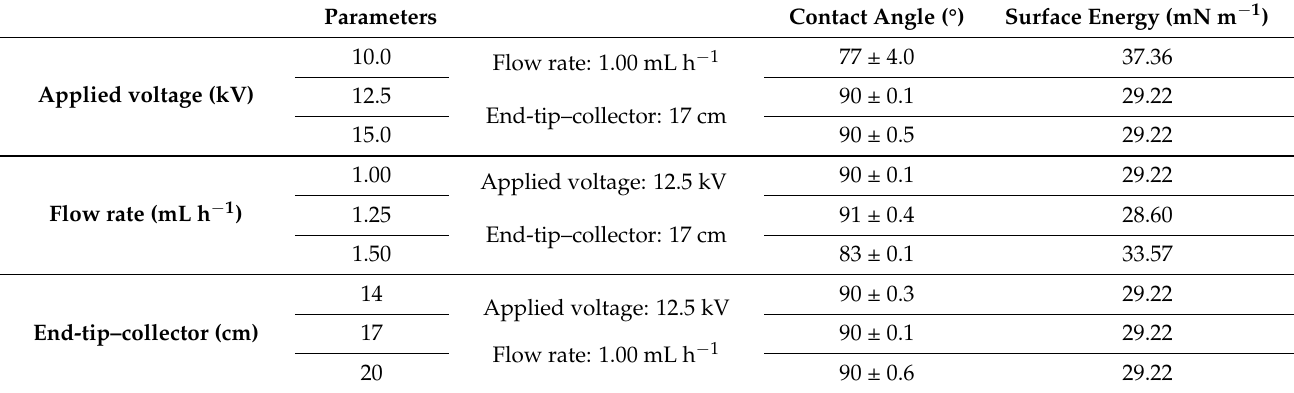
Table 6. The effect of system parameters applied for the fabrication of TPU fibers containing 20 wt % LO on the contact angle and surface energy of the